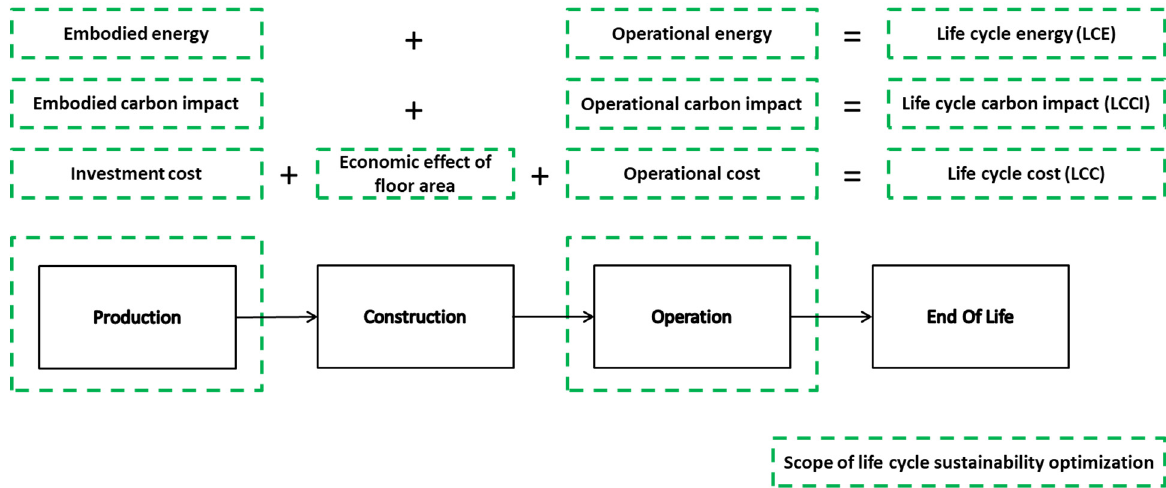
Figure 1. An overview of the scope of life cycle sustainability optimization in this study.